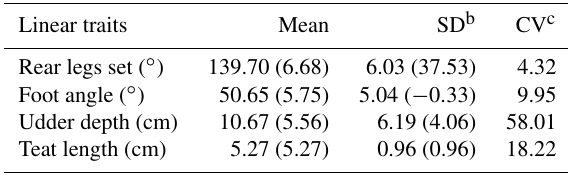
Table 1. Description of the dataset. Table 2. Phenotypic and standard deviation of the dataset a .